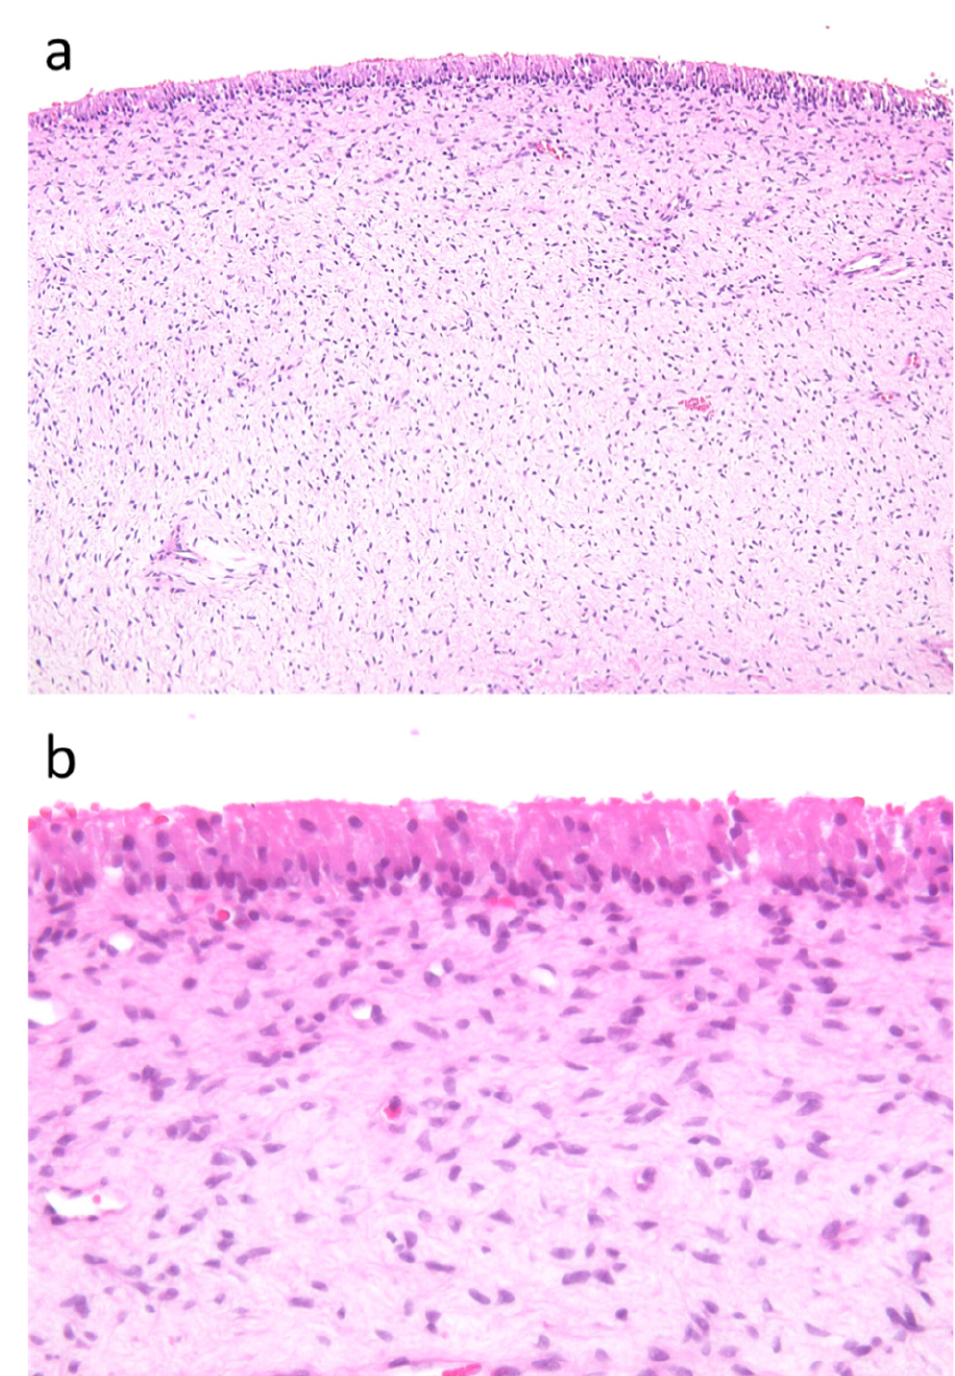
Figure 3. Histological findings of primordial odontogenic tumor. ( a ) The tumor is composed of cellular myxoid connective tissue (100 × ). ( b ) Tumor cells are spindle-shaped, lack cellular atypia and mitotic activity, and are covered by columnar epithelium (200 × ).